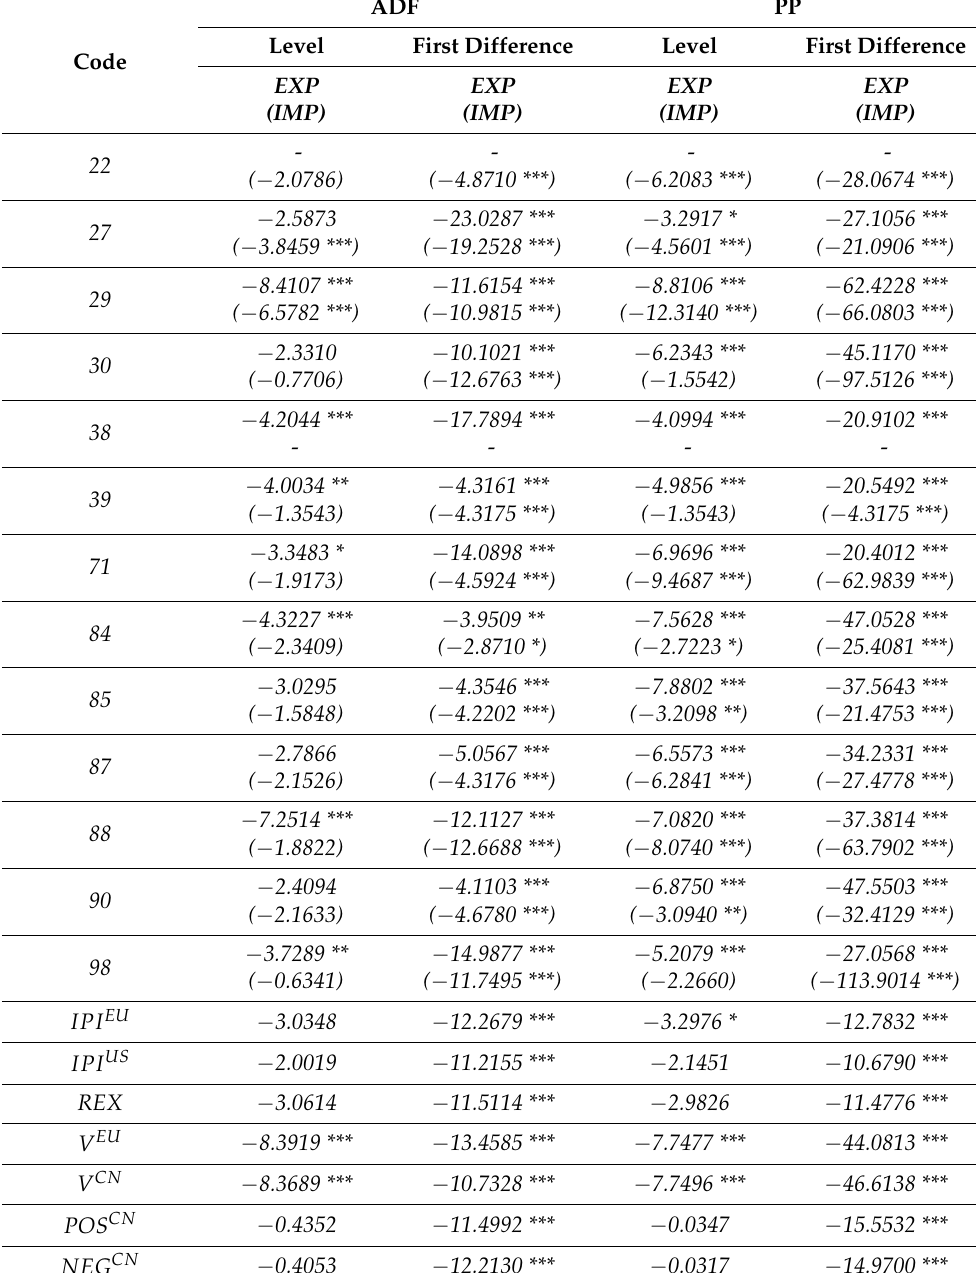
Table 2. Results of unit root